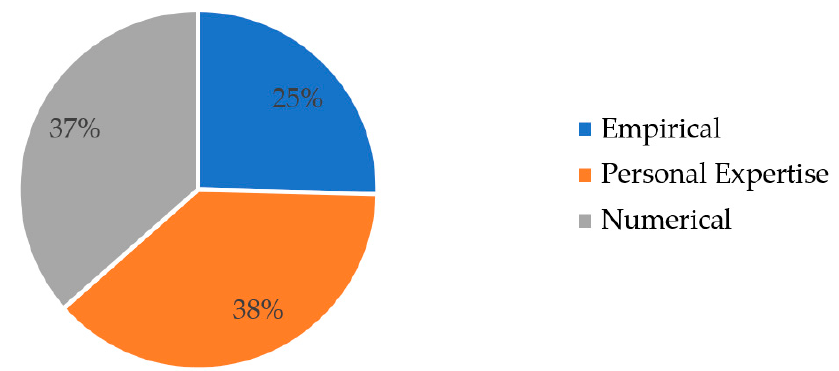
Figure 5. Ratio of the method that is used for design stopes in the mines.